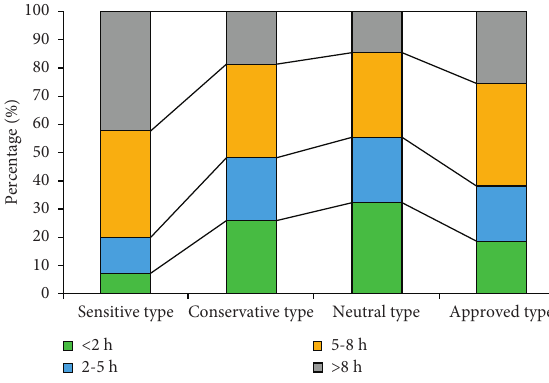
Figure 12: Parking time of drivers in the four